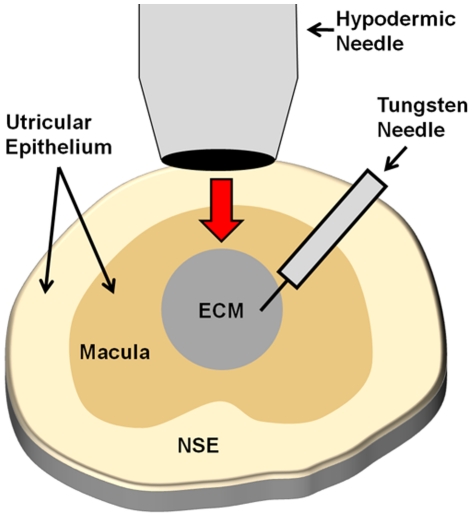
Wounding assays in the macula of the gravity-sensitive utricle.Located centrally in the utricular epithelium is the macula (dark tan), which is made up of a single layer of epithelial cells called supporting cells intermixed with sensory hair cells. The non-sensory epithelium (NSE, light tan) surrounds the macula and is comprised of just non-sensory epithelial cells. These epithelial cells reside on their native extracellular matrix, which is in turn anchored by underlying stromal cells. For wounding assays, an electro-polished hypodermic needle is pressed into the epithelium at the center of the macula, and the cells within the lesioned area are excised with a sharpened tungsten needle exposing the underlying native ECM (gray).